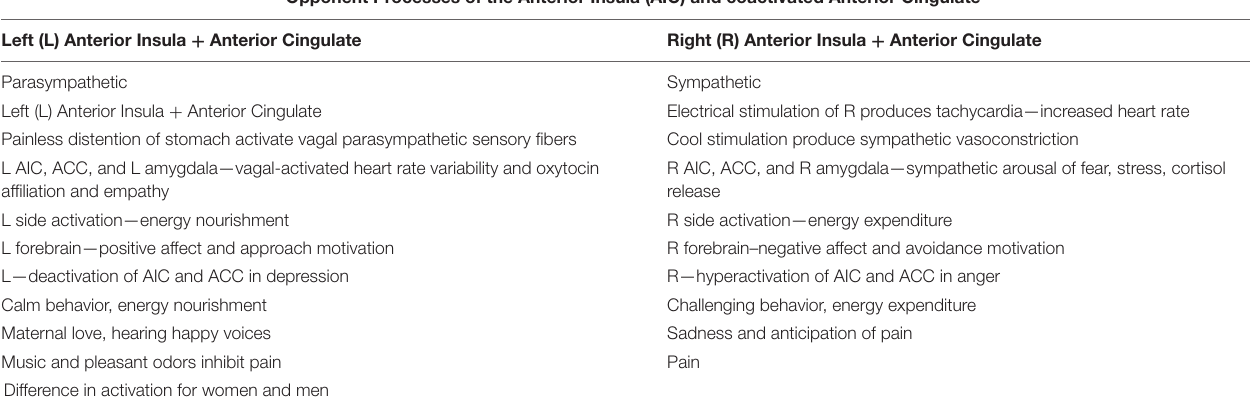
TABLE 1 | Opponent processes of the anterior insular cortex (AIC) and co-activation of anterior cingulate cortex (ACC). Opponent Processes of the Anterior Insula (AIC) and coactivated Anterior Cingulate Left (L) Anterior Insula + Anterior Cingulate Right (R) Anterior Insula + Anterior